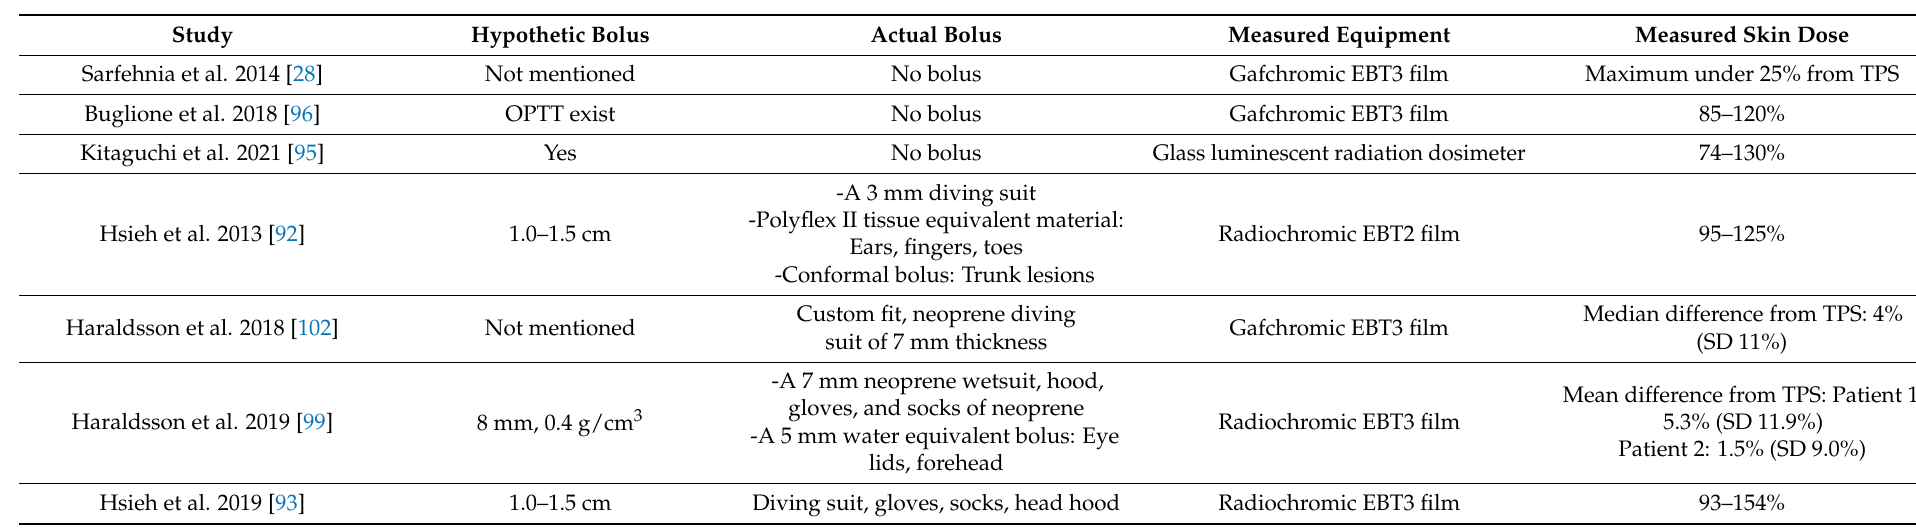
Table 2. Skin dose measurement during clinical